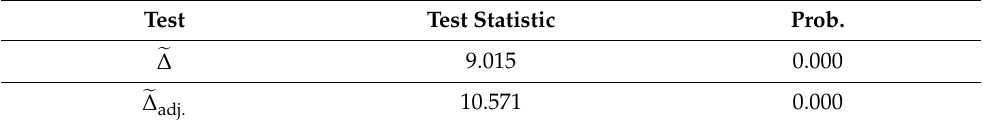
Table 5. Homogeneity tests’